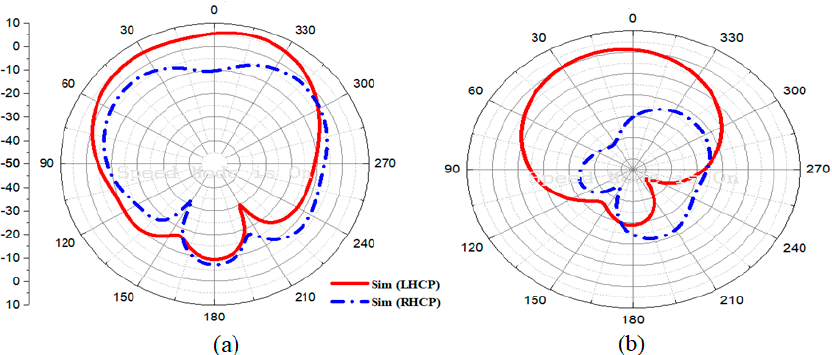
Figure 5. Simulated radiation pattern: ( a ) LHCP and RHCP at 0°; ( b ) LHCP and RHCP at 90°.